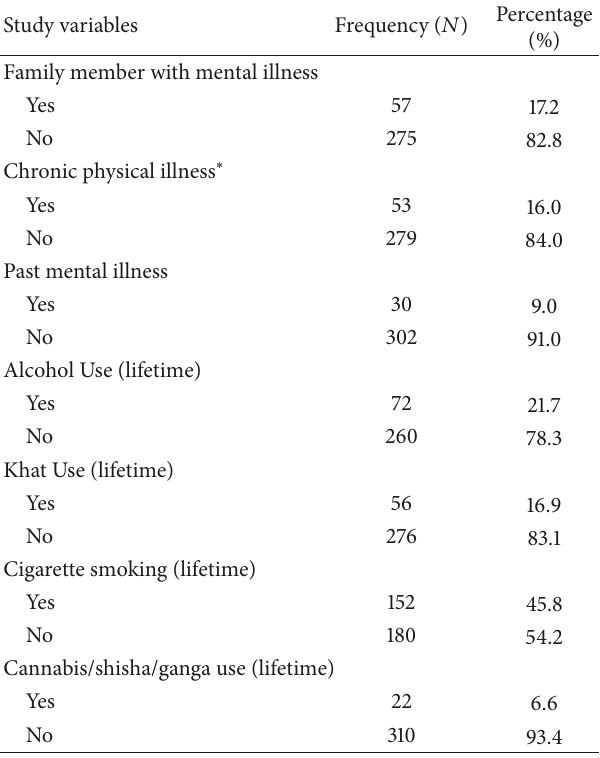
Table 2: Clinical factors and Lifetime substance use characteristics of study participants among prisoners in Jimma town prison, South West Ethiopia, June 2017 ( 𝑁 = 332